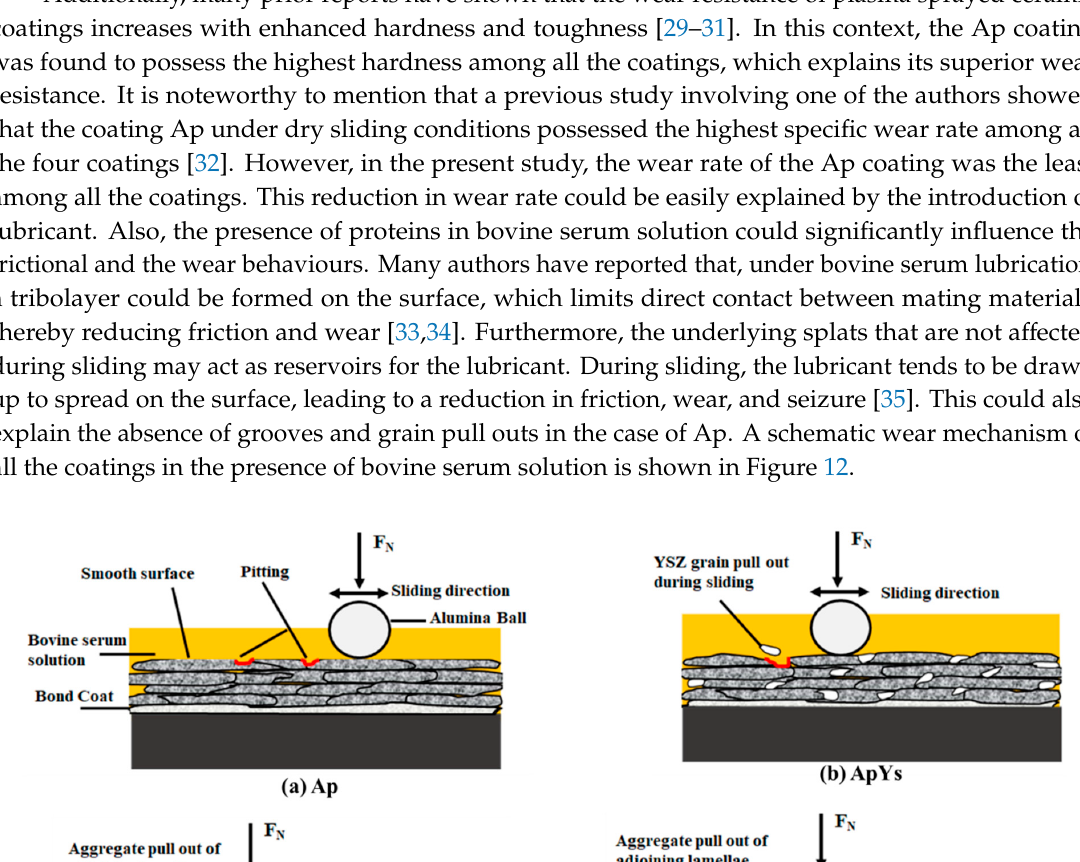
Figure 11. Worn surface morphologies at different magnifications in the case of ( a ) As, ( b ) AsYs, ( c ) Ap, and ( d ) ApYs coatings.